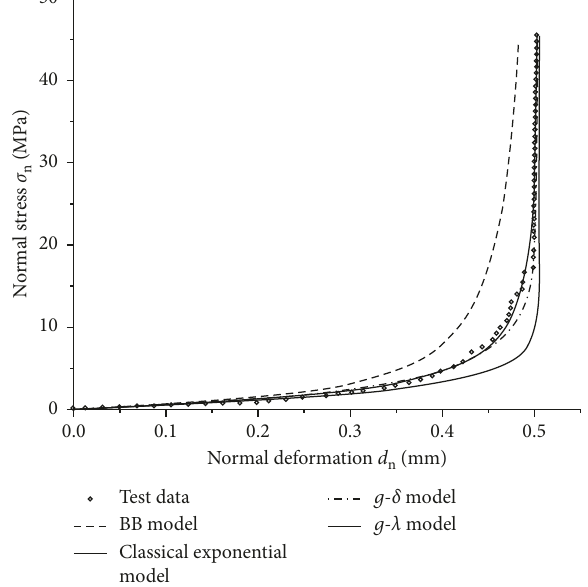
Figure 1: Scheme of the g - λ model with different values of λ , the BB model, and the classical exponential model of normal de- formational behavior of a single joint (where λ i 1 , 2 , (cid:31)